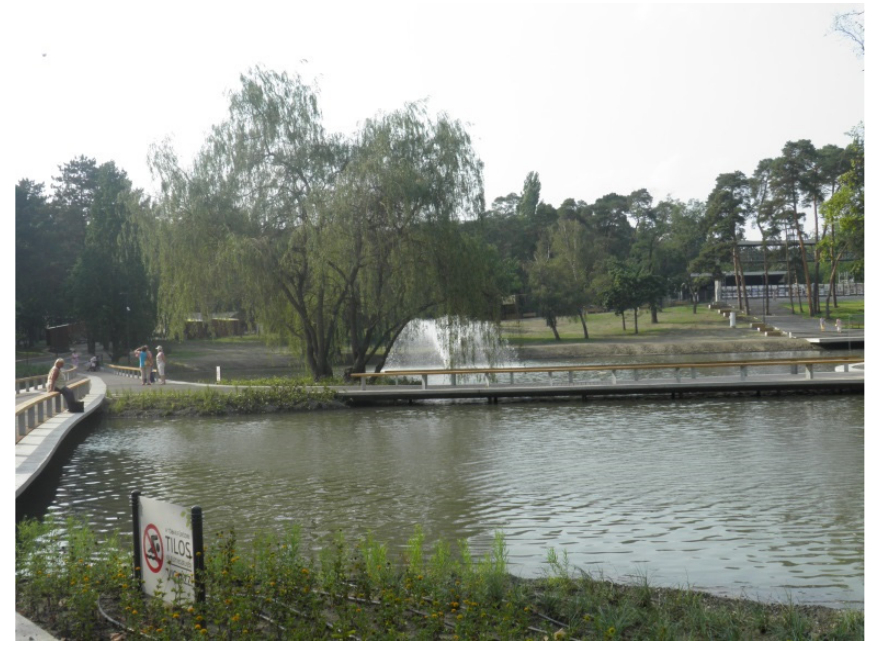
Figure 14. Increased water surface in the western part of the Great Forest Park. Source: own collec- tion.